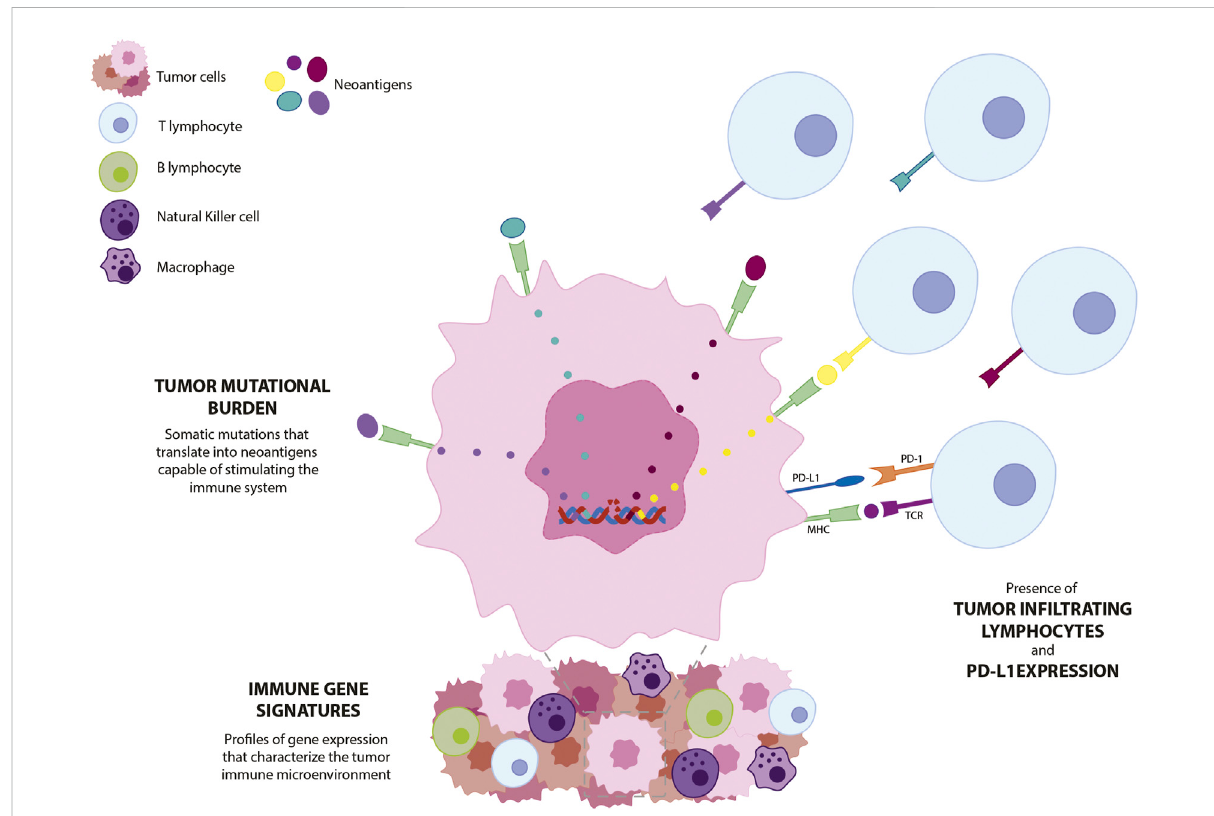
FIGURE 1 Schematicrepresentation of biomarkers currently explored in TNBC.Pointmutations in tumor cells translate into expressionof tumor-speci fi c neoantigens. Neoantigens induce T lymphocyte in fi ltration and increased expression of PD-1 and PD-L1 checkpoint molecules. Gene pro fi ling of tumor biopsiesallows thecharacterization oftheimmune components ofthetumor.PD-L1 — programmed death-ligand 1; PD-1 — programmedcell death protein 1; MHC — major histocompatibility complex: TCR — T-cell